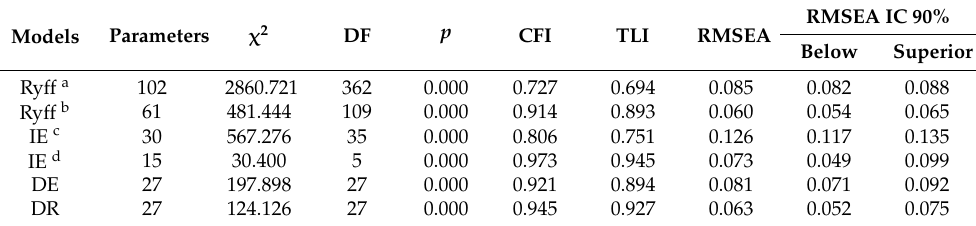
Table 1. Overall adjustment indicators of the measurement